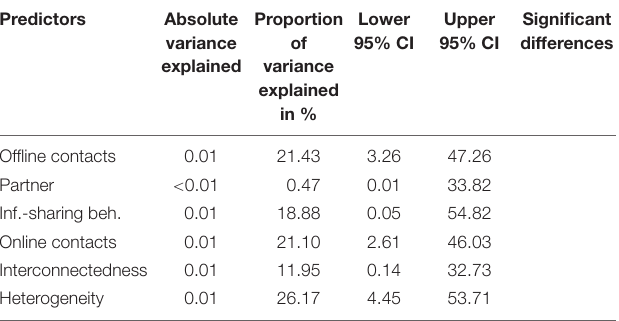
TABLE 6 | Relative importance analysis